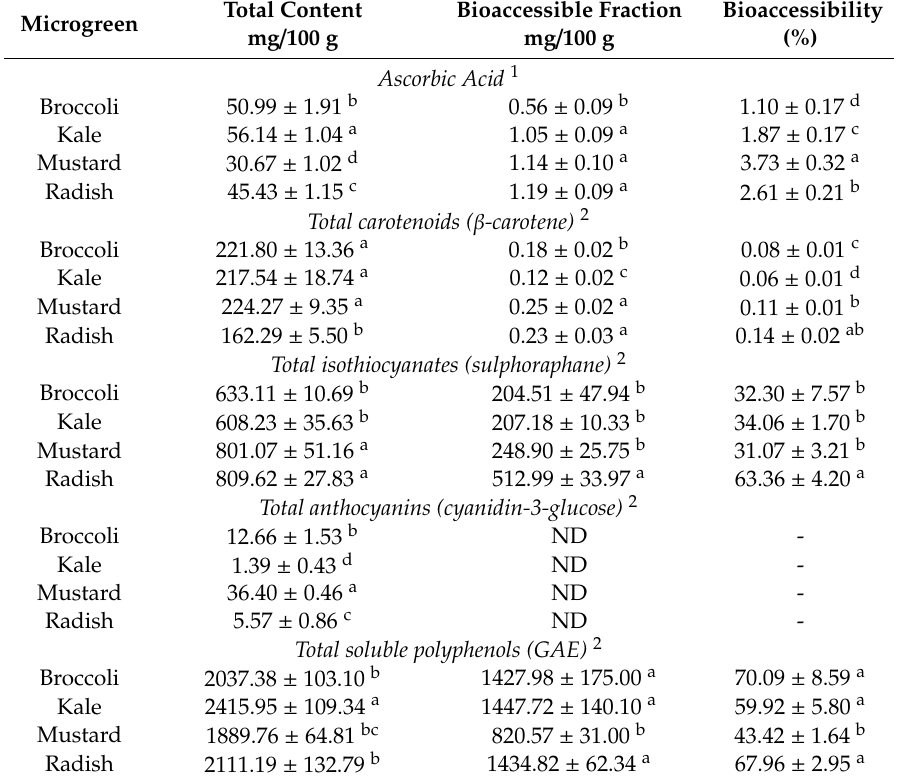
Table 1. Antioxidant bioactive compounds content in broccoli, kale, mustard and radish microgreens before and after simulated gastrointestinal